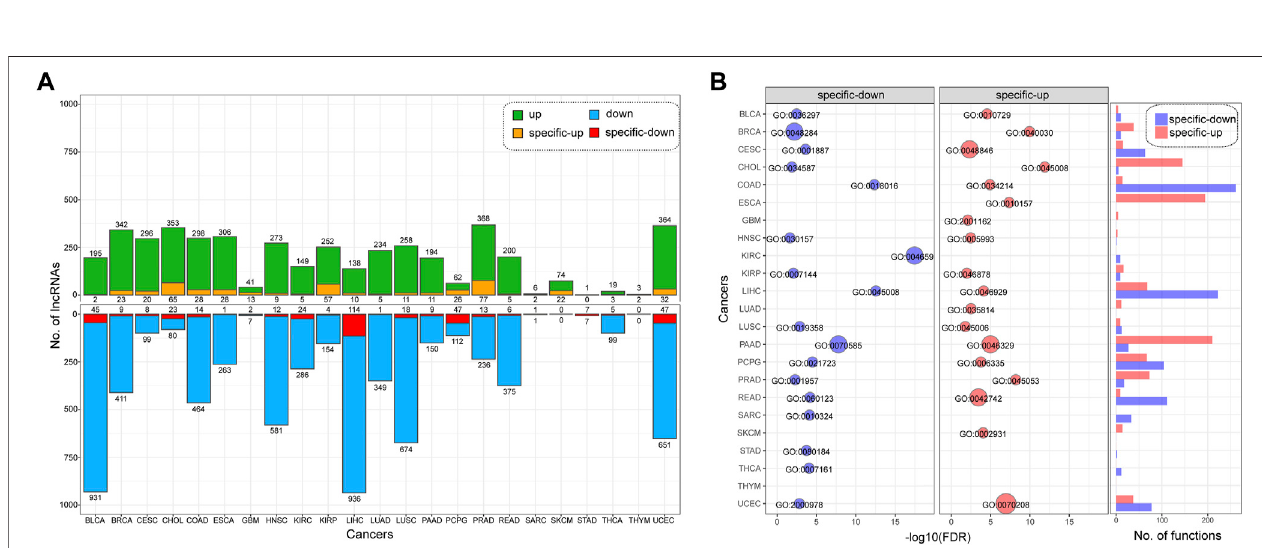
FIGURE4| Thecancer-speci fi clncRNAswithdifferentialmethylation (A) Thenumberandproportion ofcancer-speci fi clncRNAs.Greenrepresentsup-methylated lncRNAs,bluerepresents down-methylatedlncRNAs,yellowrepresentsspeci fi callyup-methylatedlncRNAs,andredrepresentsspeci fi callydown-methylatedlncRNAs (B) The functions of speci fi c lncRNAs in each cancer type. Red represents the functions of up-methylated lncRNAs, while blue represents the functions of down- methylated lncRNAs.